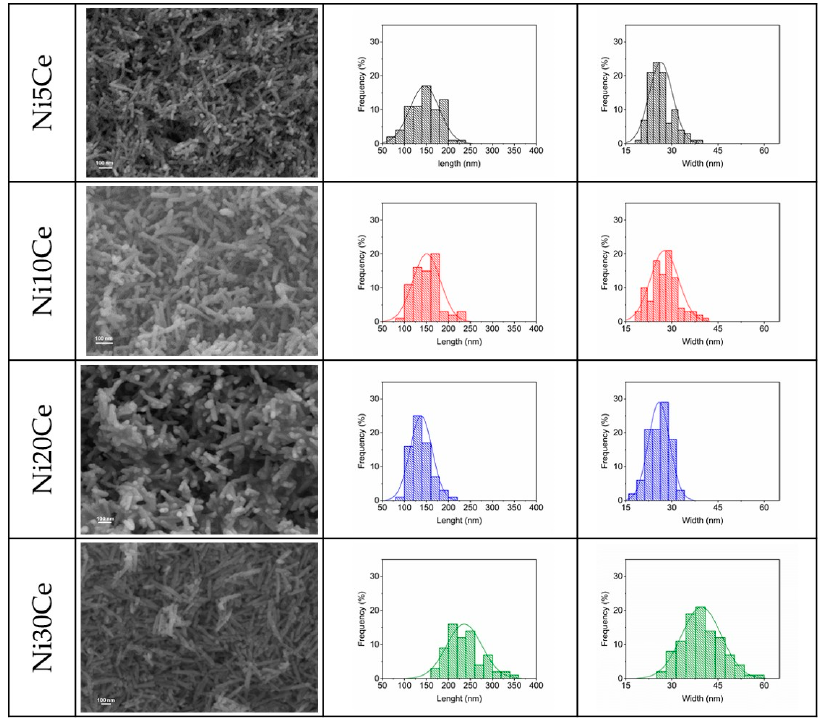
Table 4. Average values with standard deviation of length, width and aspect ratio of ceria nanorods.